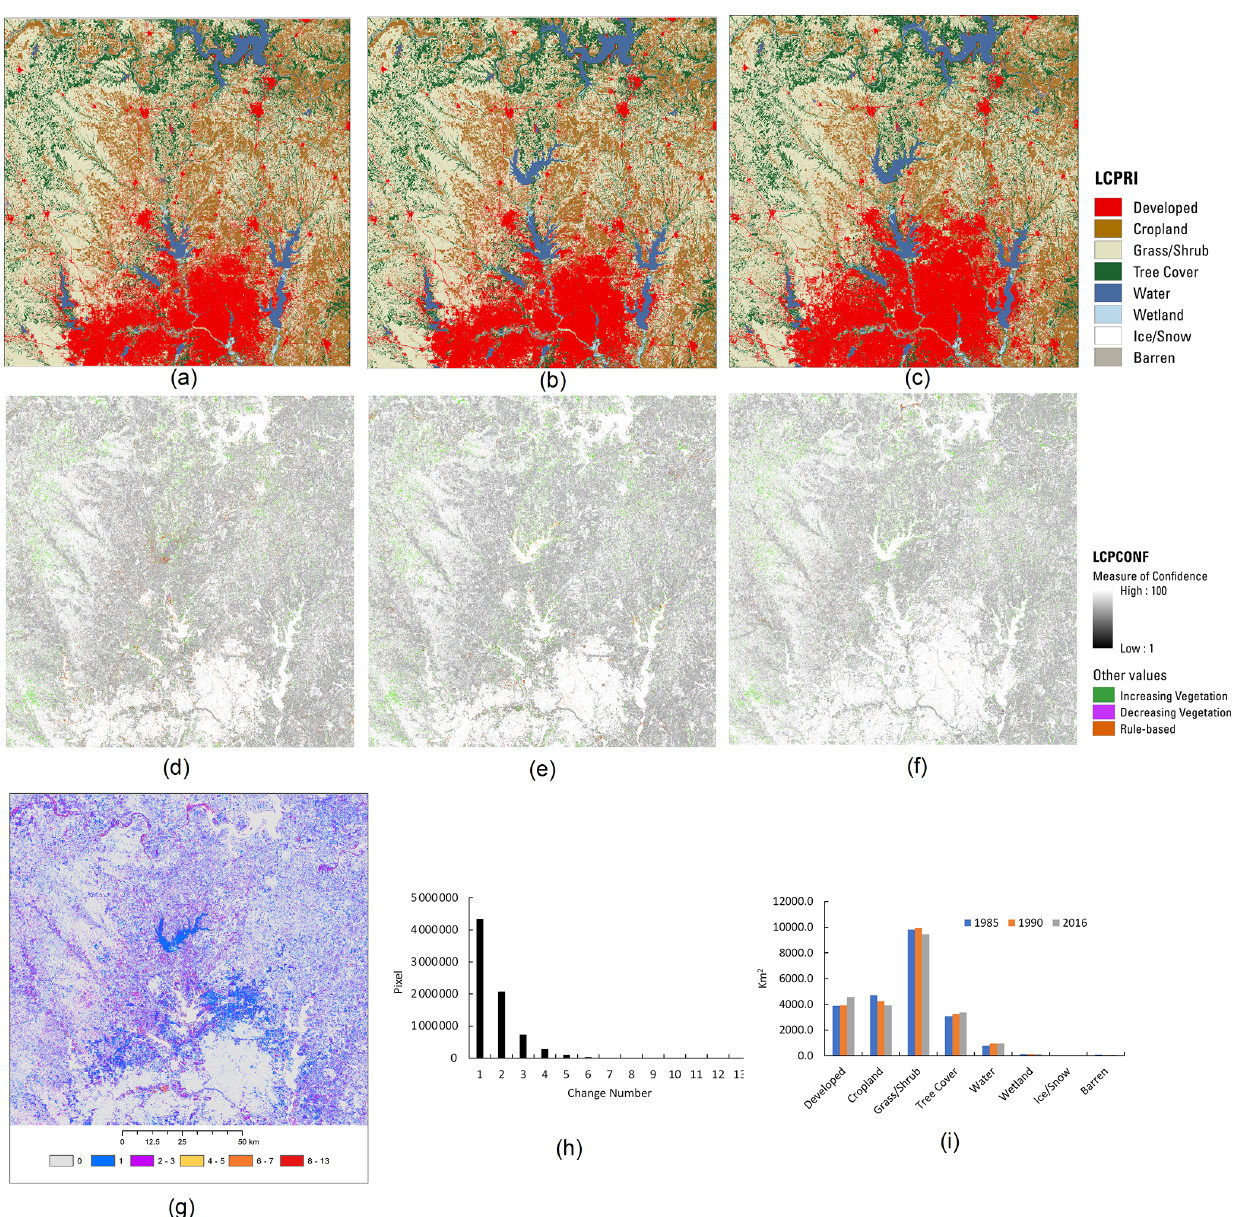
Figure 8. Primary land cover and confidence in 1985 (a, d) , 1990 (b, e) , and 2016 (c, f) and change in 1985–2017 (g) , the frequency of land cover change ( x axis) from 1985 to 2017 and numbers of pixels ( y axis) of these changes (h) , and areas ( y axis) of different land cover ( x axis) in the three times for the ARD tile 16_14 (i)